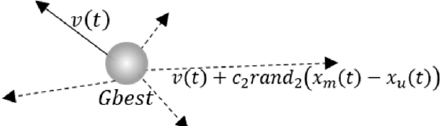
Figure 3. Diagram of the velocity of the best global particle. Improved inertia